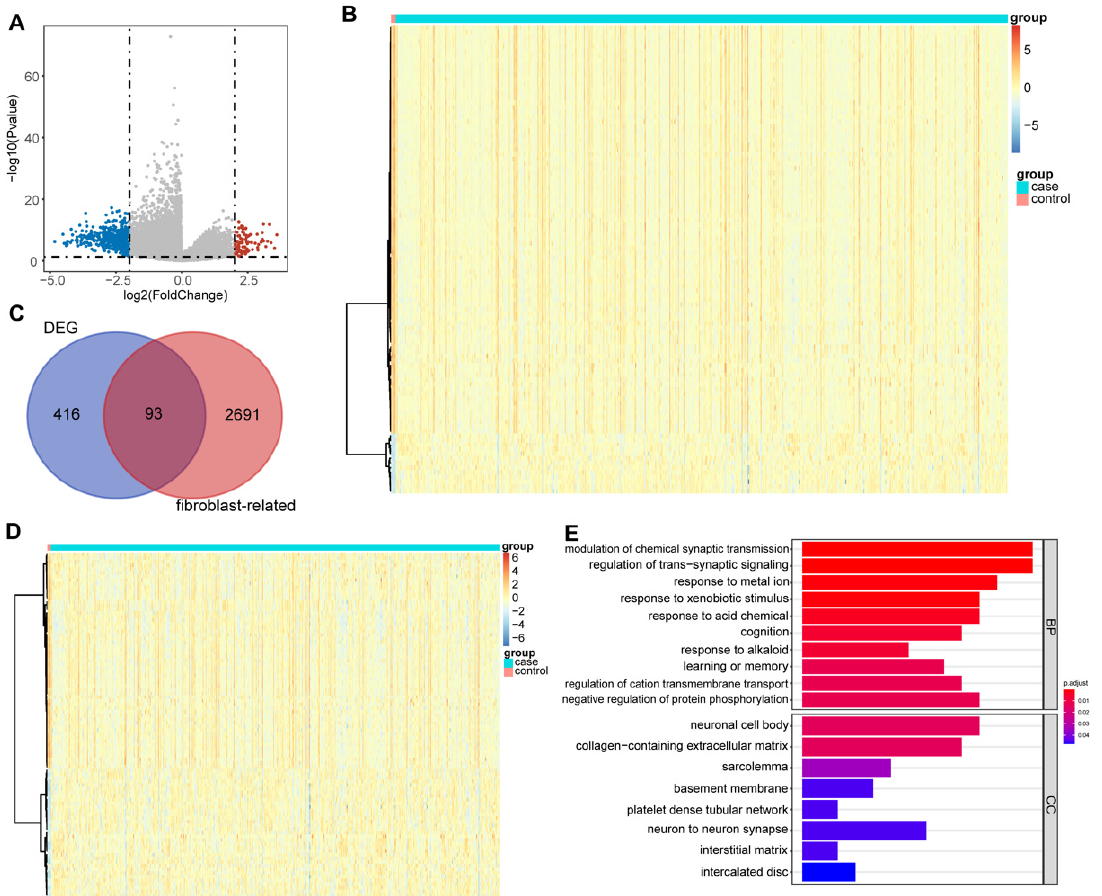
Figure 1. Identification of 93 DEFRGs: ( A ) volcano plot of DEGs between the glioma and normal samples from the TCGA cohort, blue dots: down-regulation and red dots: up-regulation; ( B ) heatmap of top 100 DEGs between the glioma and normal samples, each small square represents one sample; ( C ) Wayne diagram of DEFRGs; ( D ) heatmap of the expression of DEFRGs; and ( E ) top 10 GO items in each category.